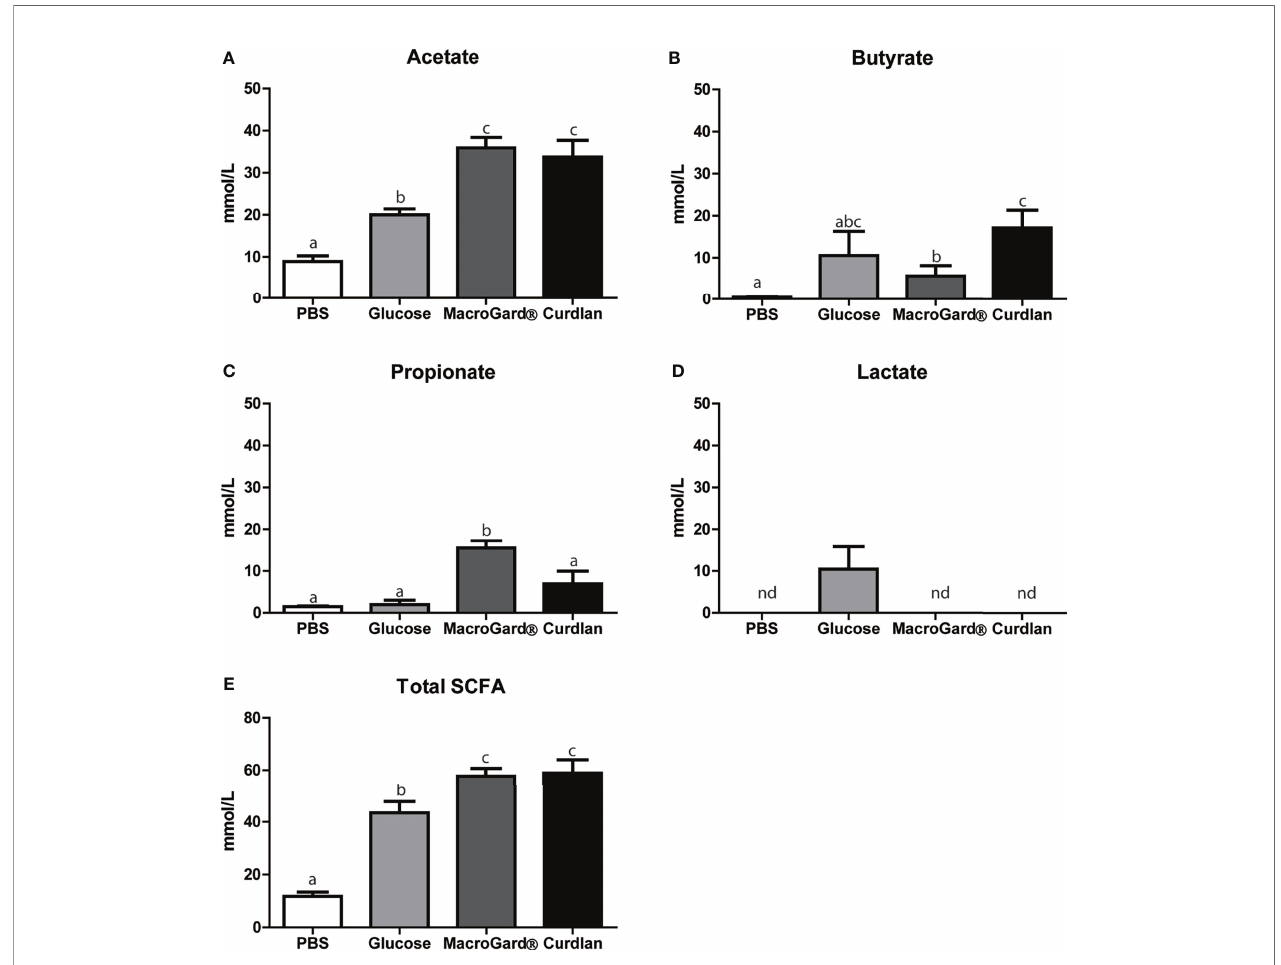
FIGURE 3 | Differential SCFA pro fi les after in vitro fermentation of b -glucan. SCFA levels in the fermentation liquid following 168 h in vitro fermentation of PBS, glucose, MacroGard ® , or curdlan. (A – E) Acetate, butyrate, propionate, and lactate, or total sum. Total SCFA levels were calculated by adding up all analysed SCFA levels including branched chain short-chain fatty acids. Bars indicate mean ± SD of n = 5 independent intestinal pools. Signi fi cant differences between groups were assessed by one-way ANOVA followed by Tukey test (A, D, E) or by Welch ’ s ANOVA followed by the Games – Howell test (B, C) . Groups with different letters are statistically different from one another. (D) The annotation “ nd ” indicates that lactate was not detected in these